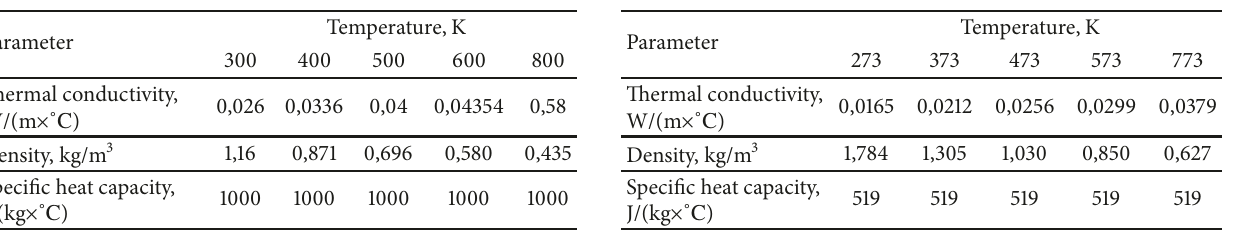
Table 2: Thermophysical properties of air. Table 3: Thermophysical properties of